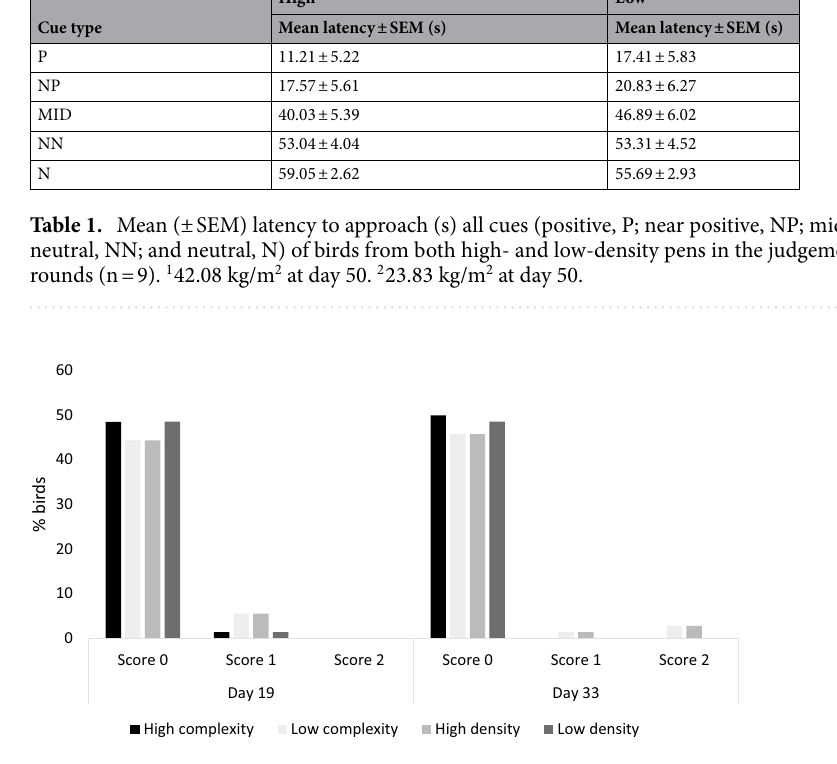
Figure 3. Percentage of birds with each gait score (ranging from 0, walks with no obvious impairments, to 2, unable to walk) in each treatment group. Percentage of birds (n = 72) in high-complexity, low-complexity, high stocking density (42.08 kg/m 2 at day 50), and low stocking density (23.83 kg/m 2 at day 50) pens receiving a gait score of either 0, 1, or